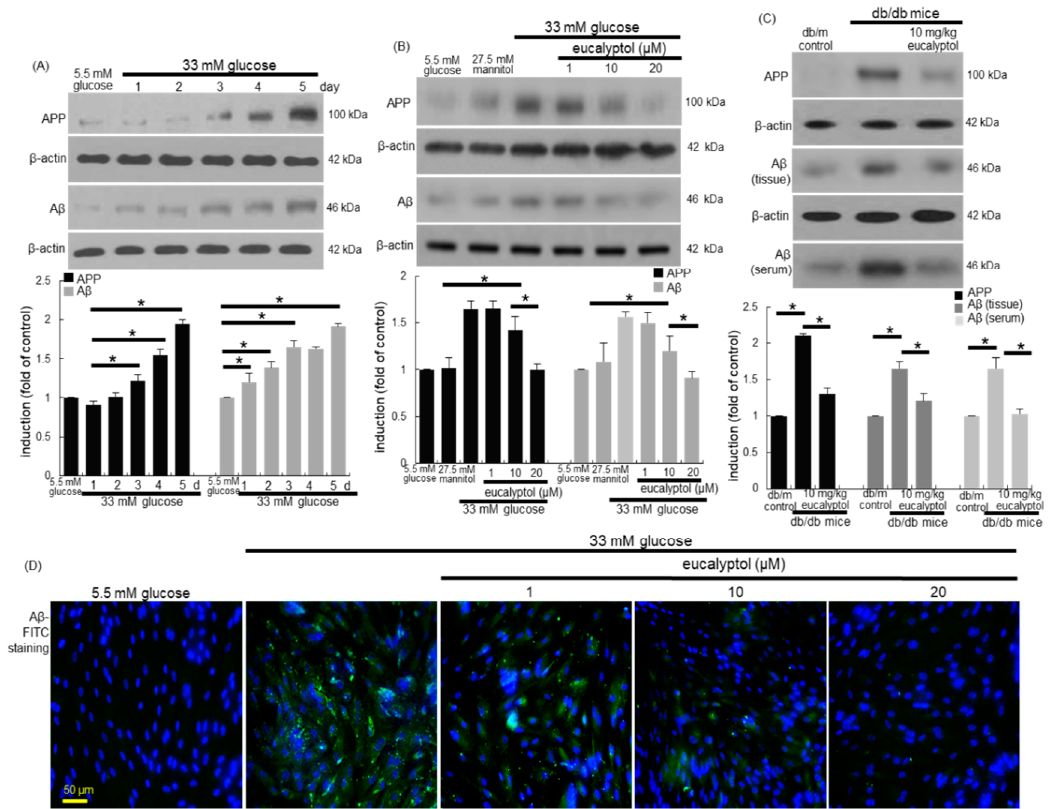
Figure 6. Temporal induction of APP and A β ( A ) and the inhibitory effects of eucalyptol on their induction ( B – D ). RPE cell lysates, eye tissue extracts and sera were subject to western blot analysis with a primary antibody against APP, A β , and β -actin for an internal control. The bar graphs (mean ± SEM, n = 3) represent quantitative results of blot bands ( A–C ). * Values in respective bar graphs indicate a significant difference at p < 0.05. For the immunocytochemical analysis of A β , green FITC-conjugated secondary antibody was used for visualizing A β induction, being counterstained with 4 ′ ,6-diamidino-2-phenylindole for the nuclear staining ( D ). Each microphotograph (mean ± SEM, n = 3) was obtained by using a microscope system. Scale bar: 50 μ m.